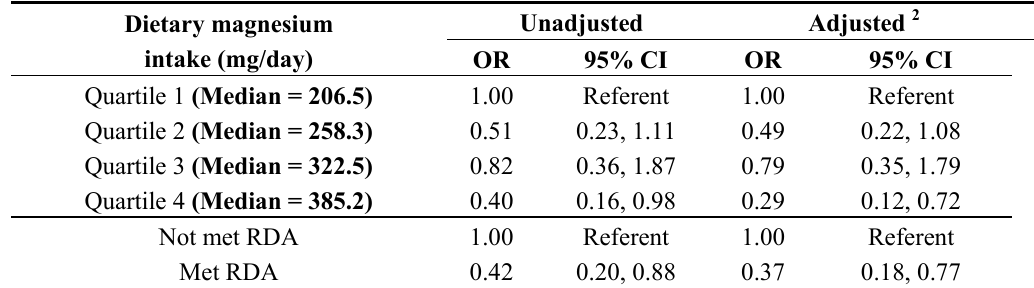
Table 3. Odds ratios (OR) and 95% conference intervals (CIs) of elevated HOMA-IR (>3.6) over three time-points from a linear mixed model among non-diabetic individuals with metabolic syndrome ( n = 234) 1